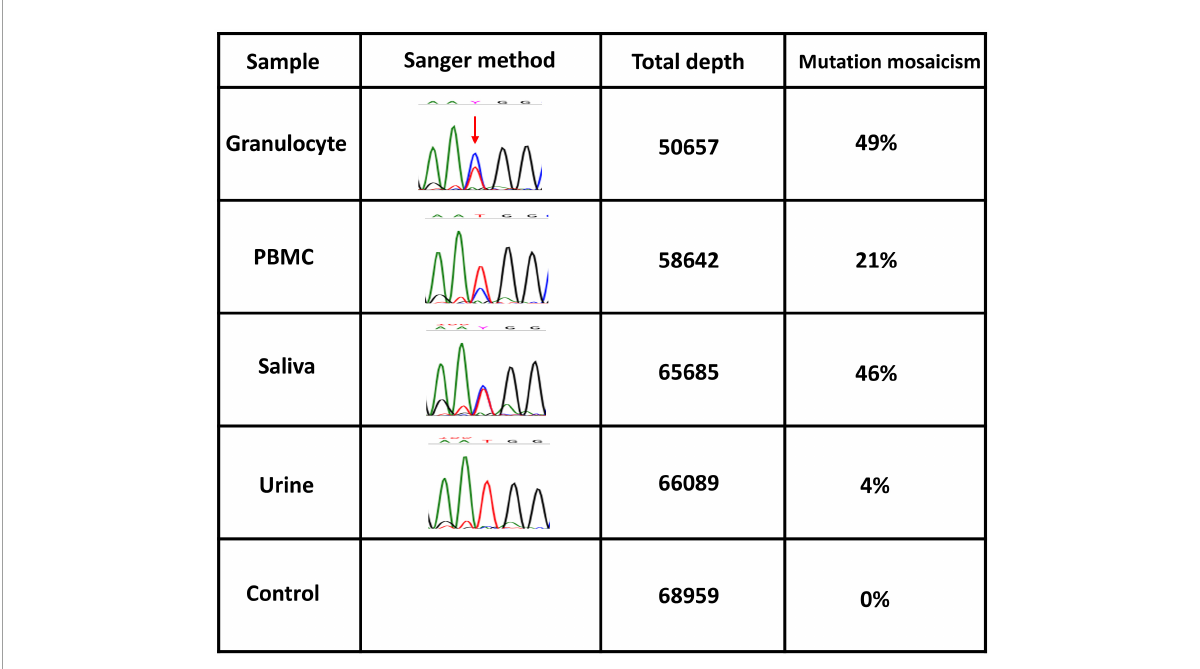
FIGURE4 Quantification of mosaicism. UBA1 somatic variants of granulocytes from peripheral blood, peripheral blood mononuclear cells (PBMCs), saliva, and urine. Mutation mosaicism was analyzed by using the MiSeq Sequencing System (Illumina, Inc.) after polymerase chain reaction (PCR) amplification of the target. The target is the UBA1 (NM_003334.4) missense mutation c.122T > C (p.Met41Thr) on chromosome X (47199052 T/C). Total depth and mutation mosaicism were measured by bam-readcount (ver 0.8.0). A commercial genome was used as a